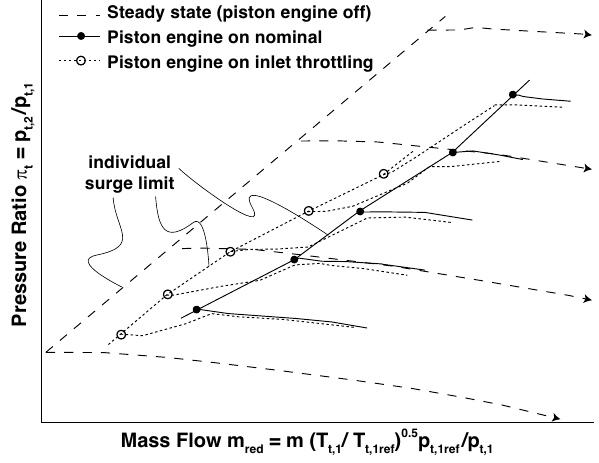
Figure 11. Surge line shift for unsteady operating